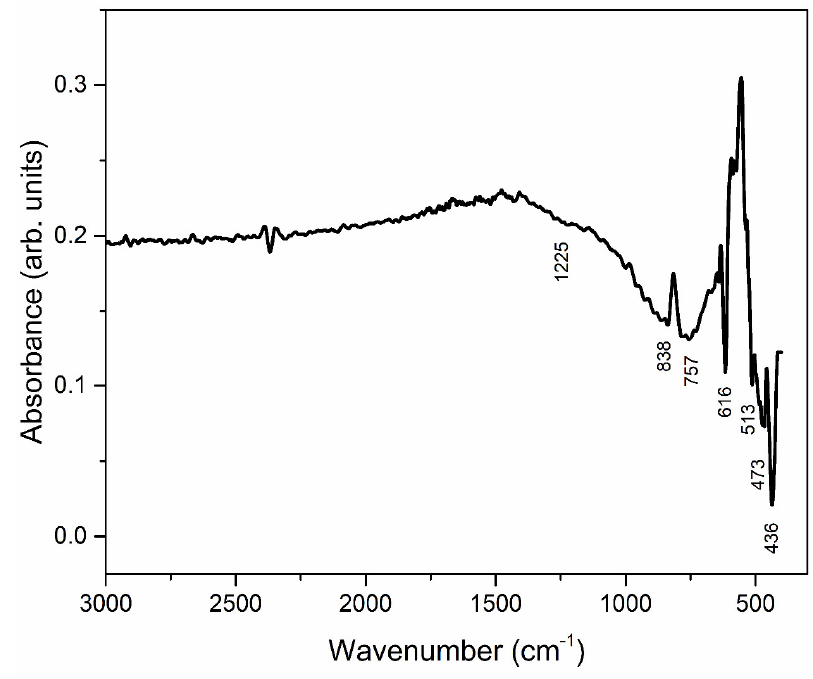
Figure 5. FTIR spectrum of BiFeO 3